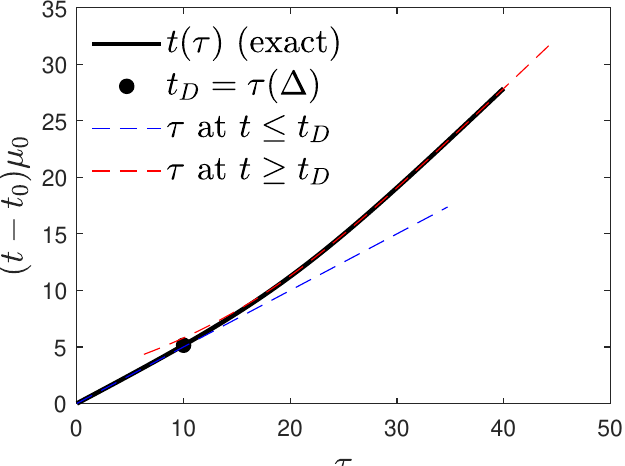
Figure 10. Real time, t ( τ ) , versus τ (solid black line) for the case of k 0 = 0.5, k 1 = 0.9, τ c = 20, ∆ = 10 at fixed constant infection rate µ 0 . The dot indicates the value at the transition time, t D (30), and the asymptotic expressions (35) and (40) for small and large times, respectively, are shown by dashed lines of different colors as